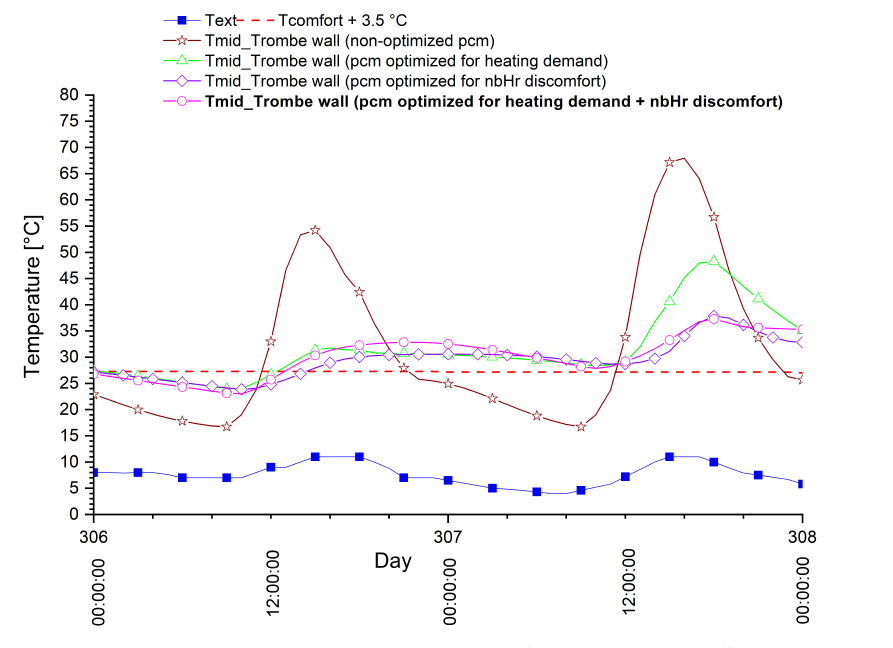
Figure 24. Temperature variations in the PCM storage wall.